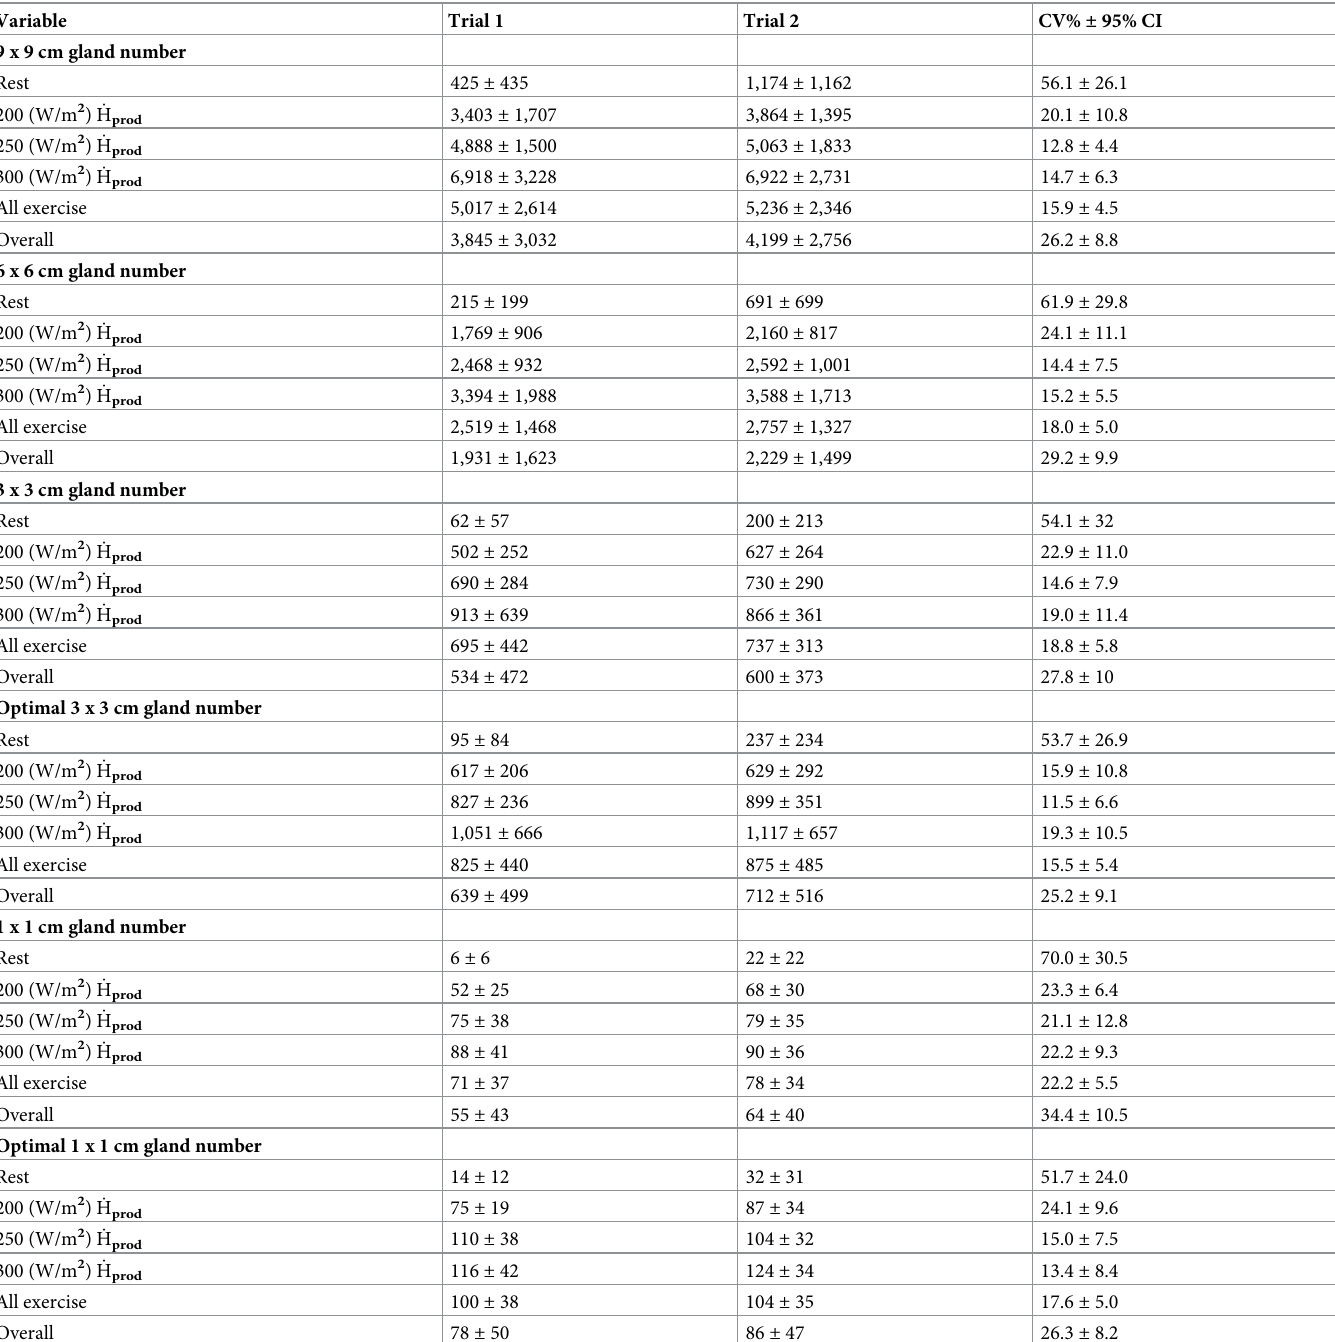
Table 2. Mean, standard deviation and reliability of sweat gland activation (gland number) at rest and a range of exercise intensities.